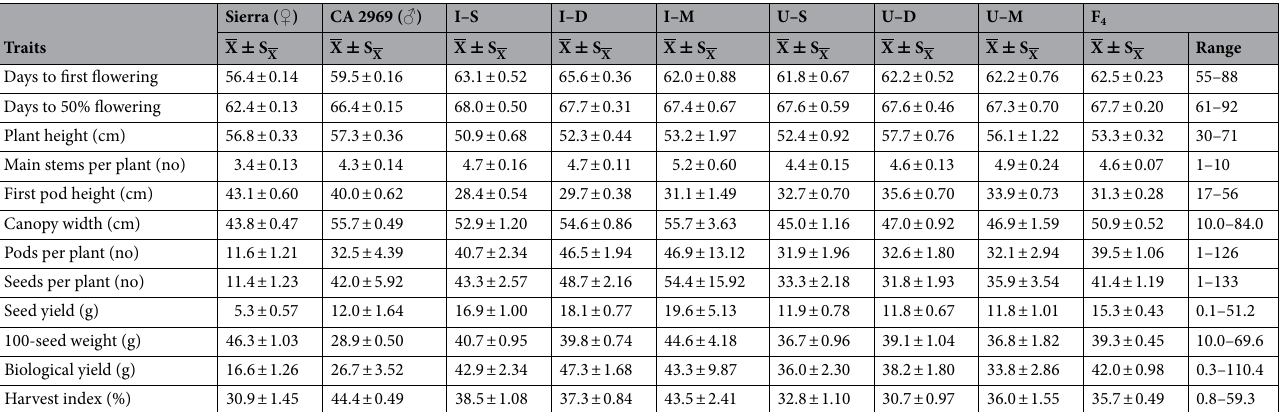
Table 2. Means ± standard errors and range for agro-morphological traits in F 4 population derived from intraspecific crosses between Sierra (single-podded and unifoliolate-leafed) and CA 2969 (double-podded and imparipinnate-leafed). I–S: imparipinnate-leafed and single-podded progeny, I–D: imparipinnate-leafed and double-podded progeny, I–M: imparipinnate-leafed and multi-podded progeny, U–S: unifoliolate-leafed